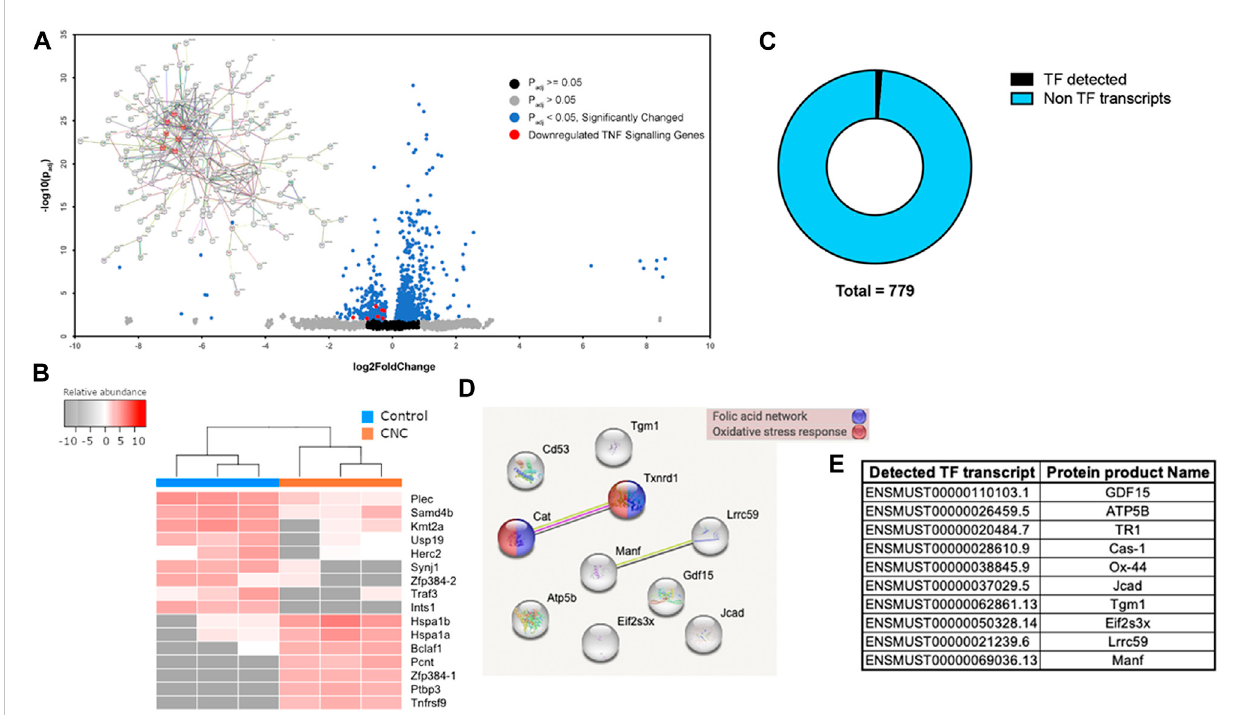
FIGURE 6 RNASeqAnalystsofgeneexpressionofBMMCgrownon12.5%CNC/agarose. (A) Volcanoplotand(inset)STRINGanalysisondownregulatedgenes. Genes related to TNF signaling pathway highlighted in red. (B) Top downregulated and upregulated transcripts in CNC samples as compared to control samples. Prior to plotting, data was subjected to a regularized logarithmic transformation that also corrects for sample size. Two transcripts of gene zinc fi nger protein 384 (Zfp384) were found deregulated, Zfp384-1 (ENSMUST00000112427) was found upregulated with a fold change of 320, while 4384-2 (ENSMUST00000112428) was found deregulated with a fold change of 52. (1 and 2 are arbitrary suf fi xes added to differentiate corresponding transcripts and are not part of the HGNC ID of the gene.) (C) ?Fs detected in RNAseq data set. Ten Ifs were detected out of a total of 779 transcripts in the RNAseqdataset. (D) ASTRINGanalysissuggeststhatTFsCat(Cas-1,catalase)andTxIMI(TRI,Thioredoxinreductase (I) arelinkedtofolkacidnetworkand